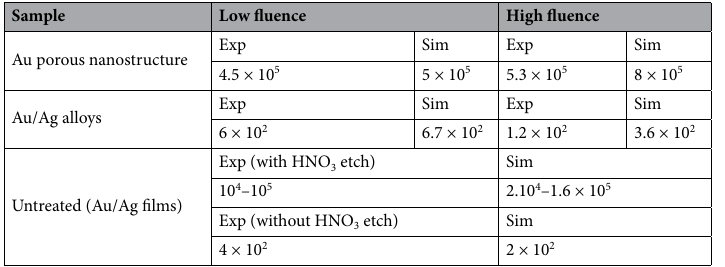
Table 1. Comparison between experimental and simulated enhancement factor (G). The method of calculation of the experimental values of the enhancement factor is detailed in the supporting information (see, also, Supplementary Fig. S3 of the supporting